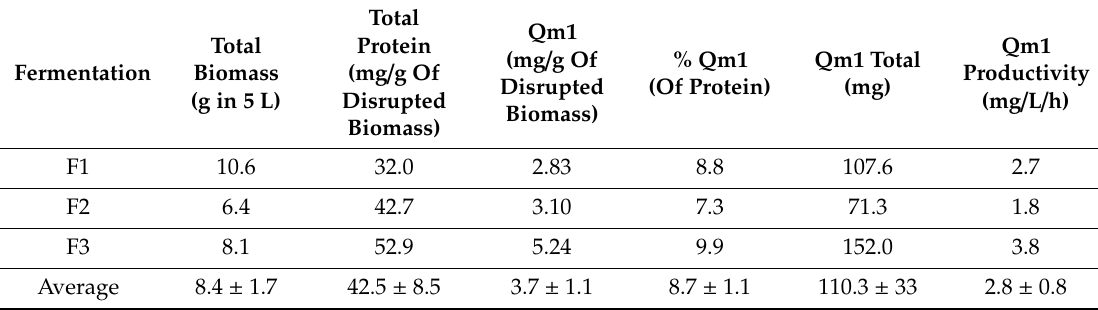
Table 1. The performance parameters of three fermentations of Qm1 expression in SHu ffl e ® T7 Express E. coli strain after 8 h of